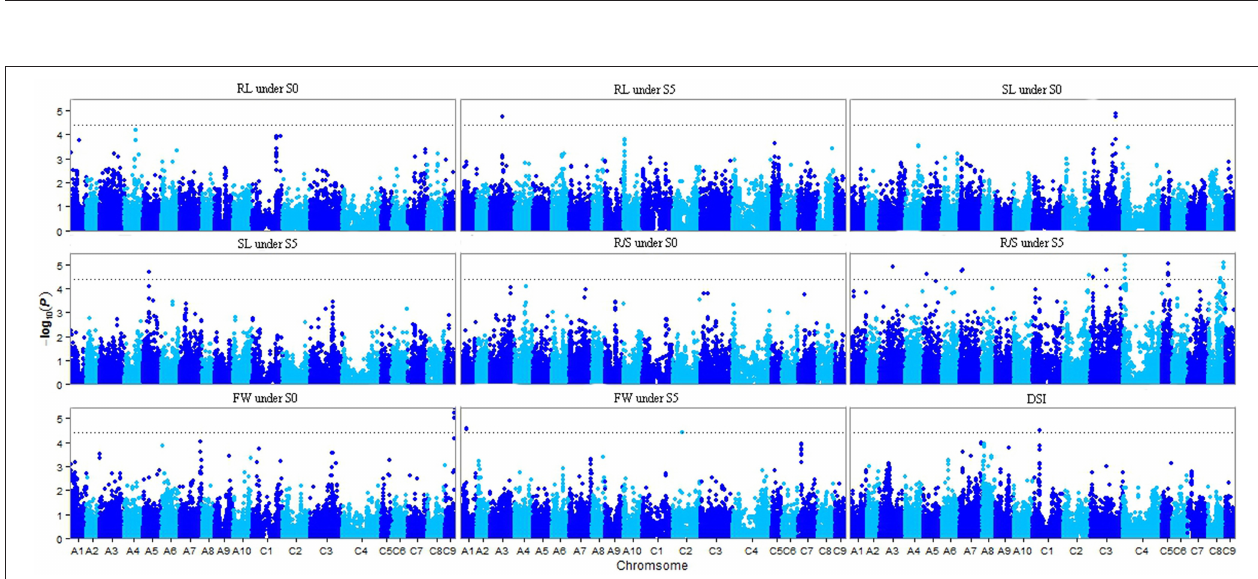
Frontiers in Plant Science | www.frontiersin.org